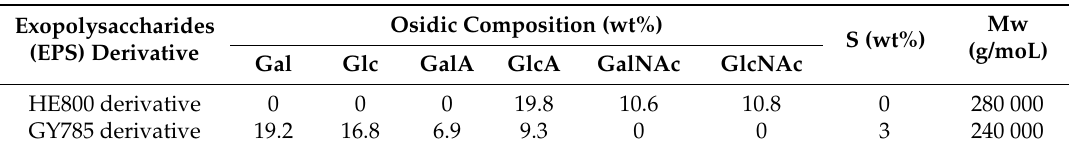
Table 1. Osidic composition (wt%), sulfur content, S (wt%), and weight-average molecular weight, Mw (g/moL), of HE800 and GY785